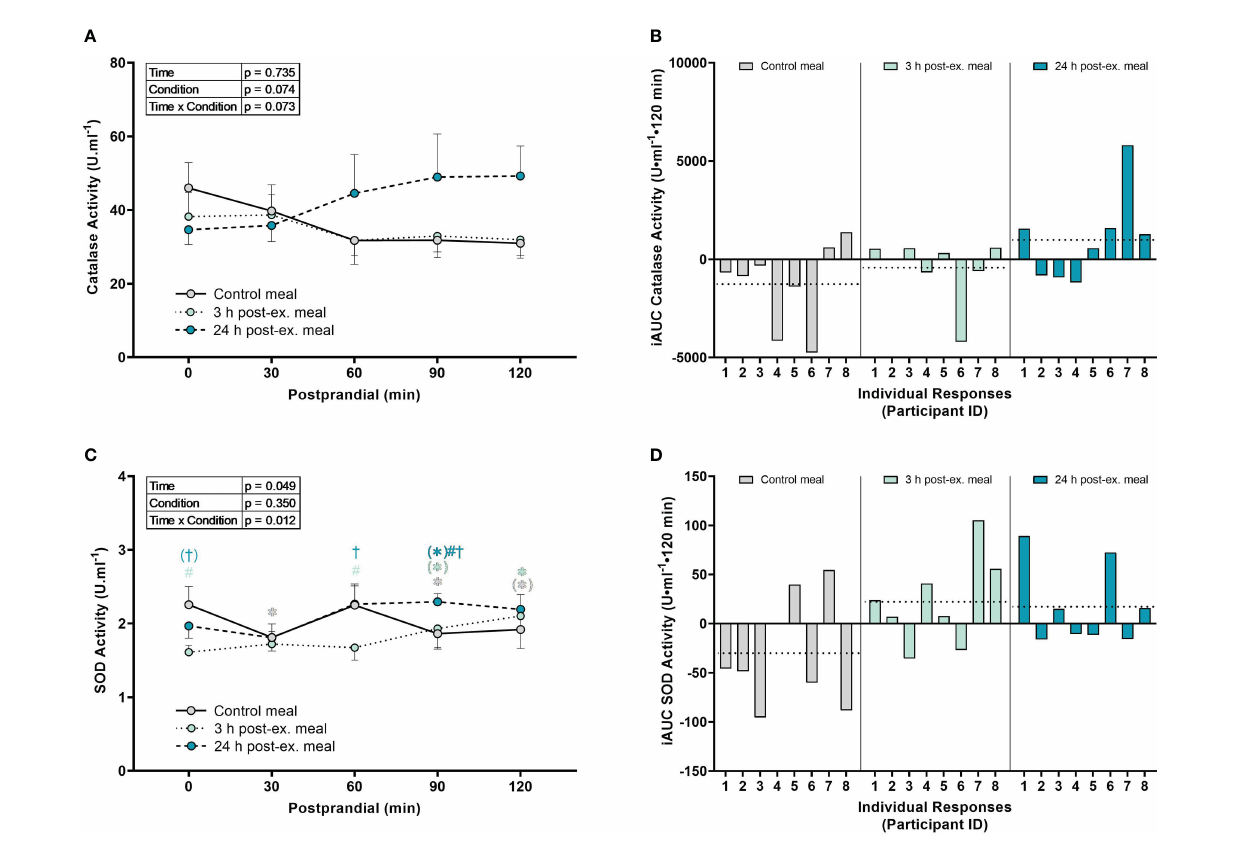
FIGURE 5 The effects of a high-glucose mixed nutrient meal on serum catalase activity (A, B) and plasma superoxide activity (SOD) activity (C, D) when ingested at rest (no-exercise control meal), and 3 h and 24 h post-exercise. Line graphs (A, C) are presented as mean ± SEM. Individual responses (B, D) are presented as the incremental area under the curves (iAUC) following meal ingestion at rest (control meal), and 3 h and 24 h post-exercise. The dotted line represents the group average iAUC value. Postprandial data (line graphs) were analyzed using a two-way ANOVA with “ time ”